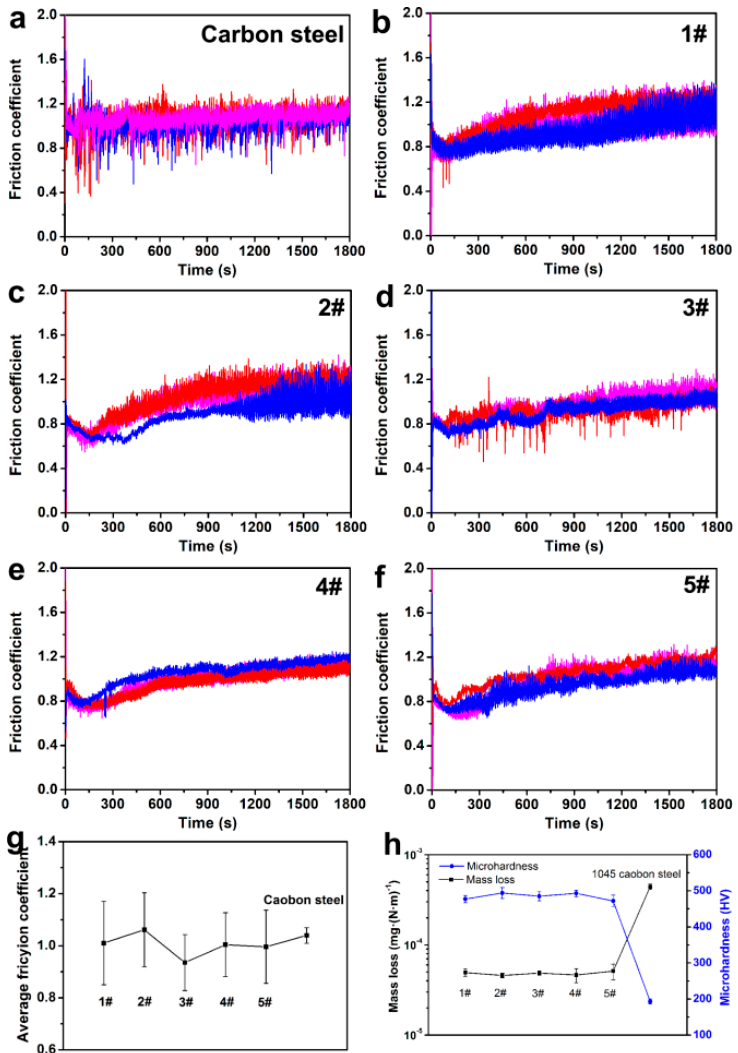
Figure 8. The friction coefficient variation curves of ( a ) the 1045 carbon steel and ( b – f ) coating specimen 1–specimen 5, ( g ) the average friction coefficient, and ( h ) the mass loss and microhardness comparison of the coating specimens and the 1045 carbon steel.